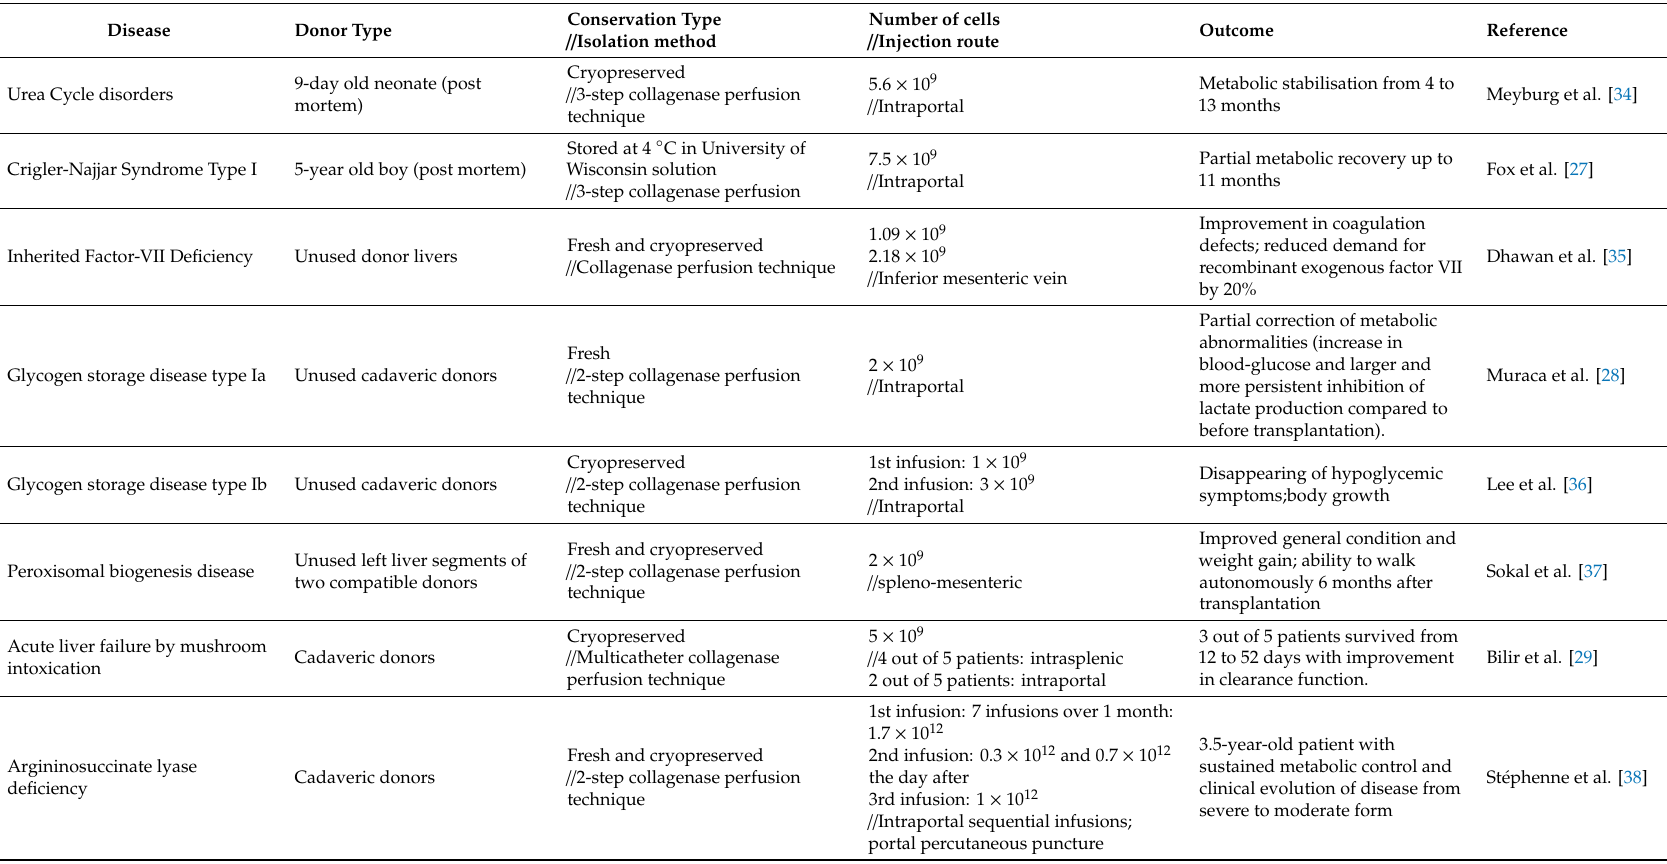
Table 1. Some examples of primary hepatocyte transplantation schemes in the clinical